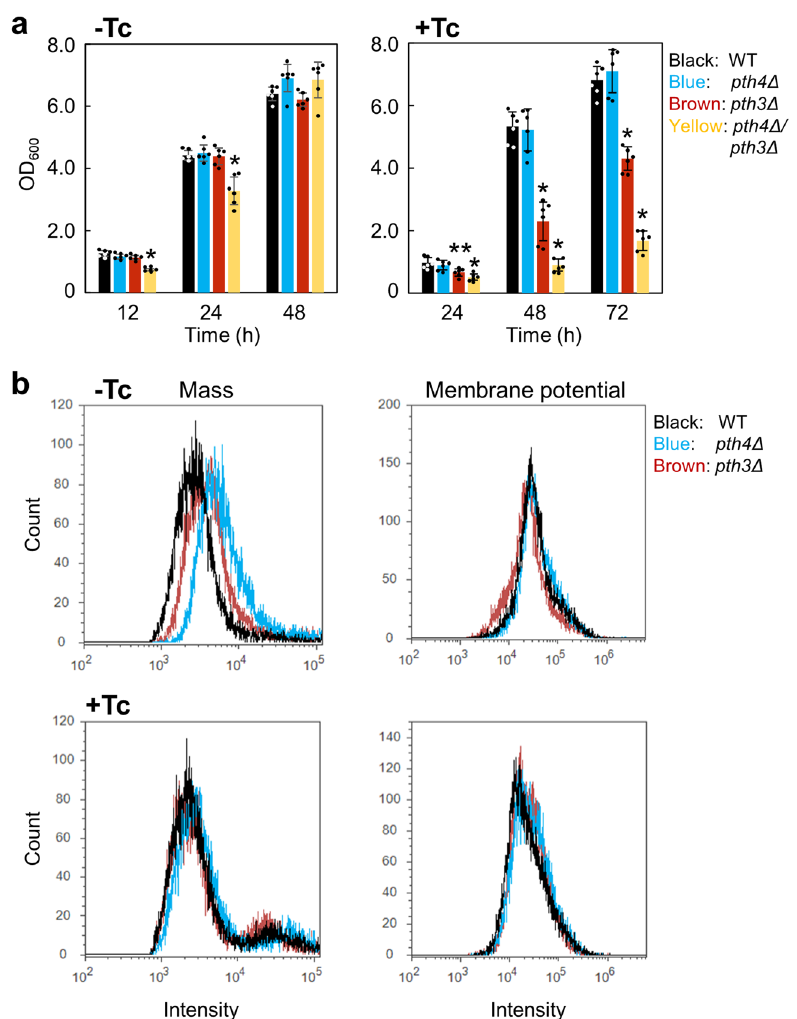
Fig. 3 Effects of the deletion of PTH4 or PTH3 on mitochondrial properties. a The three mutants and the wild type were inoculated into liquid YPG media in the absence or presence of 500 µ g/mL tetracycline (Tc) with a starting OD 600 of 0.01. Growth was monitored by measuring the OD 600 values at the indicated time points at 30 °C. Data are shown as the mean ± standard deviation of six independent experiments. Asterisks indicate signi fi cant difference from the wild type (Student ’ s t test, * P < 0.001 and ** P < 0.01). b Mitochondrial mass (left) and membrane potential (right) in the wild type (WT), pth4 Δ , pth3 Δ , and pth4 Δ pth3 Δ grown in liquid YPG media for 48 h were measured at room temperature (about 25 °C) by FCM using MitoTracker Green FM and MitoTracker Red CMXRos, respectively, in the absence or presence of 500 µ g/mL tetracycline